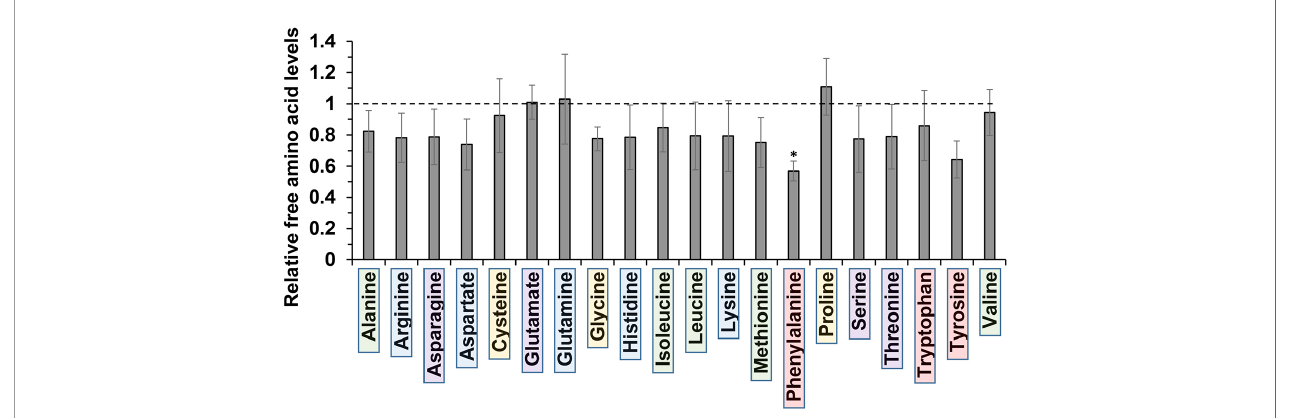
FIGURE 1 | Relative change in free amino acid levels in 5-day-old Arabidopsis thaliana seedlings grown in the presence or absence of 10 m M m -tyrosine. Arabidopsis seeds were germinated in Murashige and Skoog (MS)-agar plates in the absence or presence of 10 m M m -tyrosine ( m -Tyr). Amino acids, extracted from 50 mg of 5-day-old Arabidopsis seedlings, were identi fi ed in comparison to commercial standard compounds from each treatment (i.e., control and m -Tyr-grown seedlings), in the presence of ribitol (0.2 mg/ml) as an internal standard. Extraction, derivatization, standard addition, and sample injection were performed essentially as described previously (Lisec et al., 2006). Calculations of the relative free amino acid levels were evaluated from the relative pick area of each amino acid in untreated versus m -tyrosine-treated seedlings. The values are means of four biological replicates, while error bars indicate one standard deviation (see Table S2 ). Color boxes indicate to functional groups: in green hydrophobic side chains, blue for electrically charged side chains, purple for polar (uncharged) side chains, red for aromatic residues, and yellow indicates special side chains.